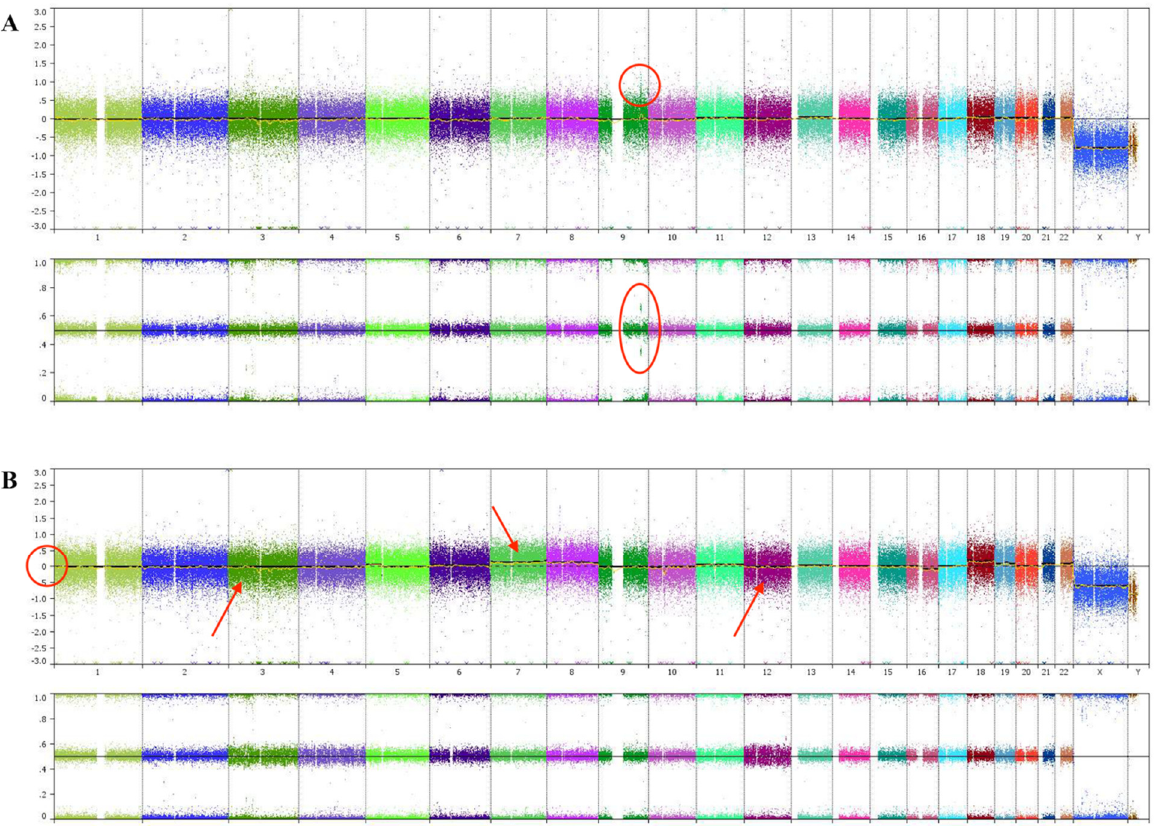
Figure 3. Raw CGH microarray relative fluorescence data for the uveal melanoma from patient #1 ( A ) and patient #2 ( B ).